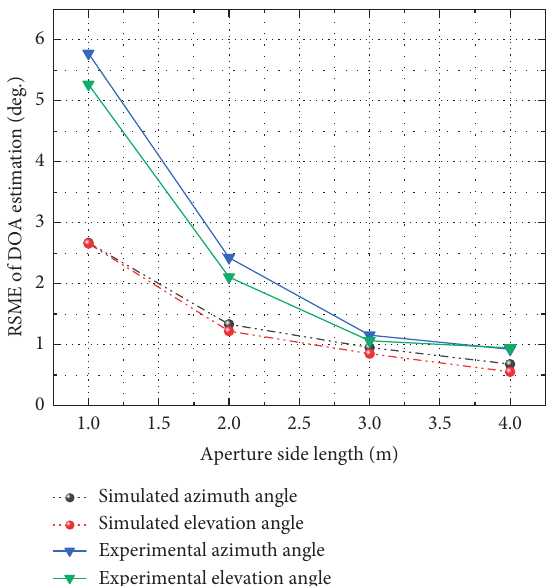
Figure 11: RMSE of DOA estimation under different aperture sizes when elevation angle is 26.93 degrees and azimuth angle is 168.88